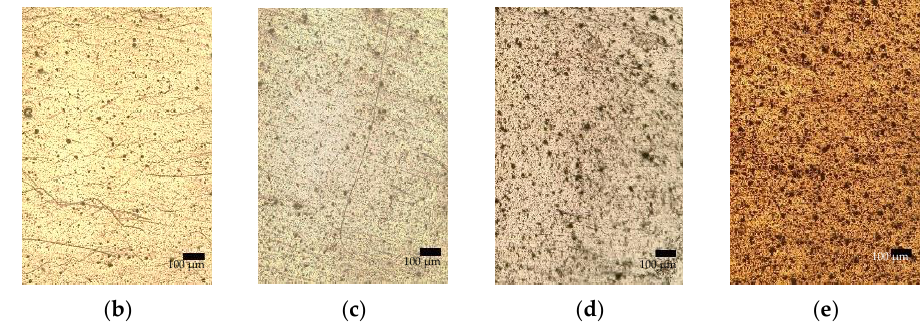
Figure 2. OM images of ( a ) LDPE/MC-0, ( b ) LDPE/MC-0.5, ( c ) LDPE/MC-1, ( d ) LDPE/MC-3, and ( e ) LDPE/MC-5.